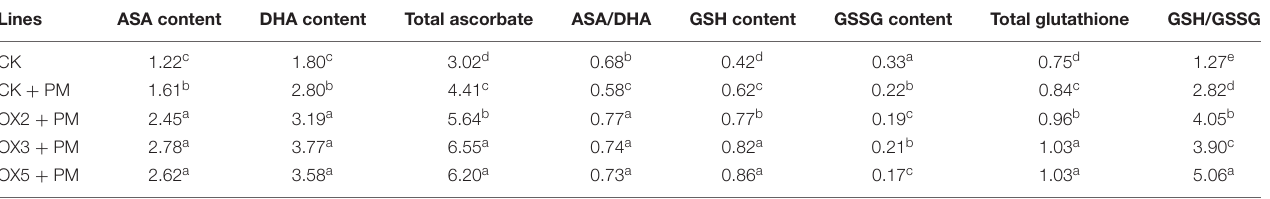
TABLE 2 | The ASA-GSH system in CsHMGB -overexpressing leaves from “D9320” genotype under propamocarb stress at 4 days.